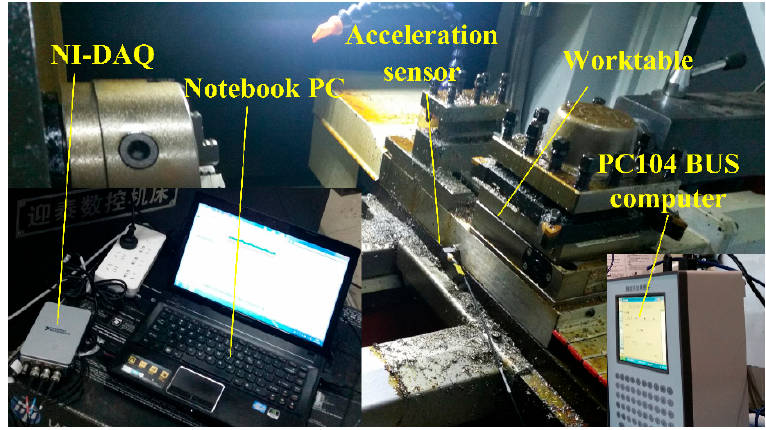
Figure 24. The flow chart of sensorless stiffness estimating method.